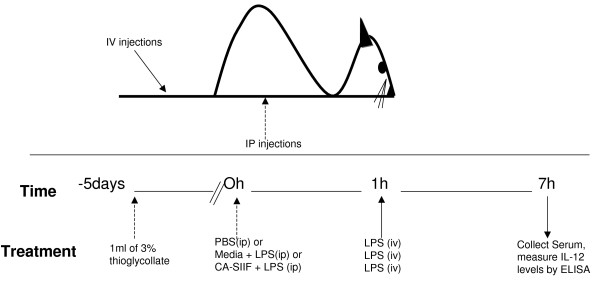
Schematic showing steps involved in the in vivo studies with CA-SIIF.